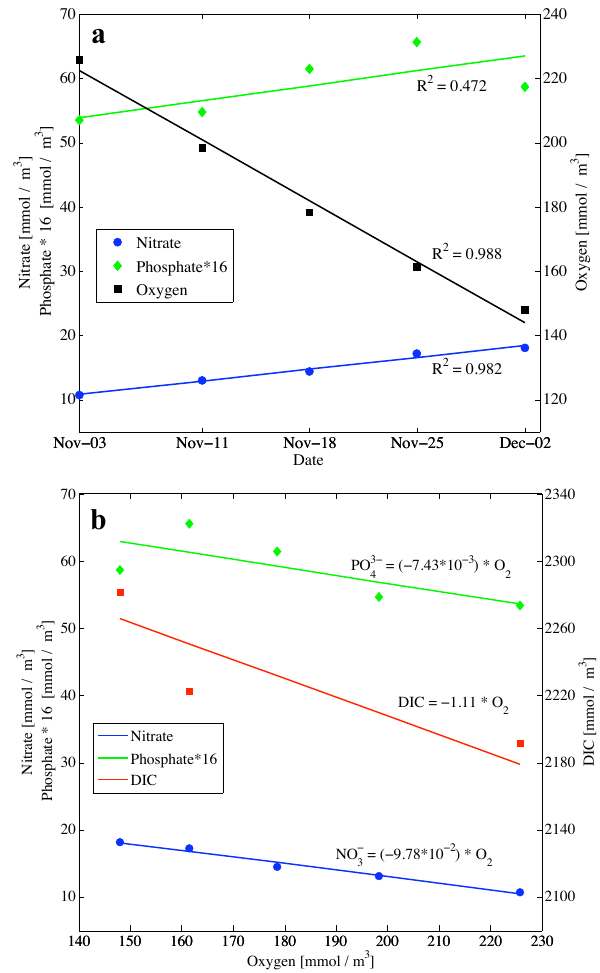
Fig. 7. (a) Time series measurements at 60m in Bedford Basin dur- ing the sampling period (as shown in Fig. 4). The R 2 values repre- sent the quality of the fit, which largely affects the uncertainties in the final flux estimates. (b) Deep-water (60m) O 2 vs. NO − and DIC. Flux ratios (listed in Table 3) are shown as the slopes of the linear regression curves. Note that phosphate regression coeffi- cients are from the original data rather than “Phosphate*16”, which is shown to better illustrate the parallel nature of the nitrate and phosphate